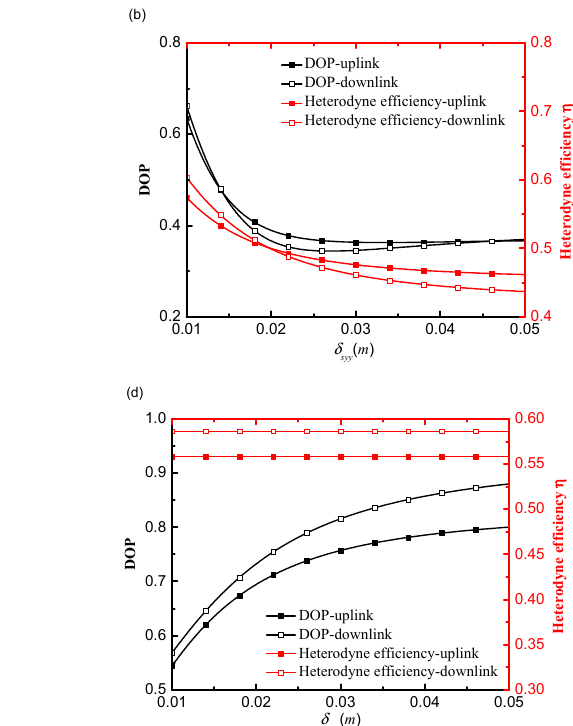
σ ly (m) (d) Figure 3. Effect of waist radius of LO beam on the heterodyne efficiency on an uplink path and a downlink path ( a ) σ lx and σ sx , ( b ) σ lx and σ sy , ( c ) σ ly and σ sx , ( d ) σ ly and σ sy . Overall, heterodyne efficiency is significantly impacted by the signal beam waist ra- dius in the Y direction component σ sy . Meanwhile, σ Sy plays a significant role in determin- ing the trend of heterodyne efficiency with increasing σ lx (or σ ly ) and this change of degree. Figure 4a–d show heterodyne efficiency and DoP as a function of δ Sxx , δ Syy , δ Sxy and δ Syx of an uplink and downlink path, respectively. As seen in Figure 4a, heterodyne efficiency increases and the DoP of the signal beam on-axis points decreases with an increase in δ Sxx . The heterodyne efficiency and DoP of the signal beam propagation on a downlink path are higher than on an uplink path. That is because the difference between uplink and downlink affected by atmospheric turbulence is expressed in the turbulence term M 3 in Equation (7), i.e., M 3 of a downlink transmission is less than that of an uplink transmission. The heterodyne efficiency and DoP on a downlink and uplink path decrease with an in- crease in δ Syy , which is consistent with the results presented in Figure 2c. The heterodyne efficiency of a downlink path is lower than that of an uplink path when δ Syy reaches a certain value. Namely, the variation of heterodyne efficiency of a downlink and uplink path is increased with an increase in δ Syy . As seen in Figure 4c,d, heterodyne efficiency remains consistent as δ Sxy and δ Syx increase, but the DoP of the on-axis points increases with an increase in δ Sxy and δ Syx . The heterodyne efficiency and DoP of a downlink path